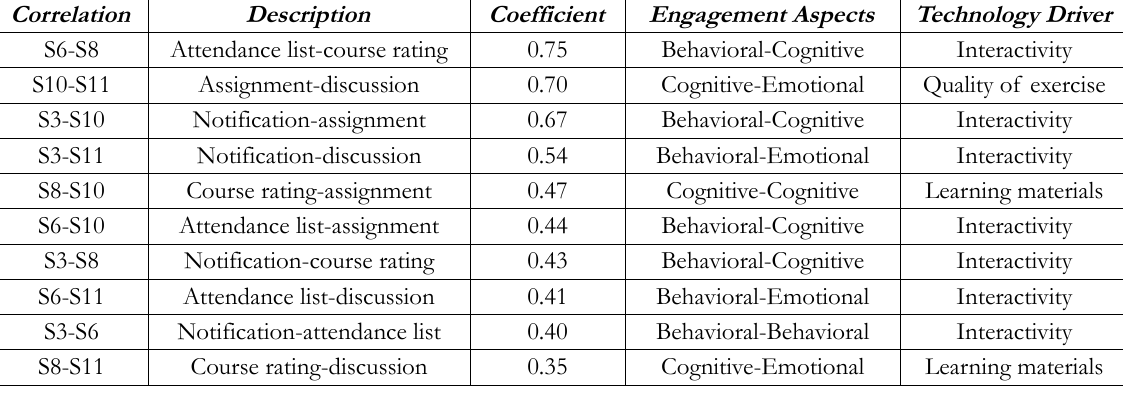
Table 5. Top-10 selected correlation